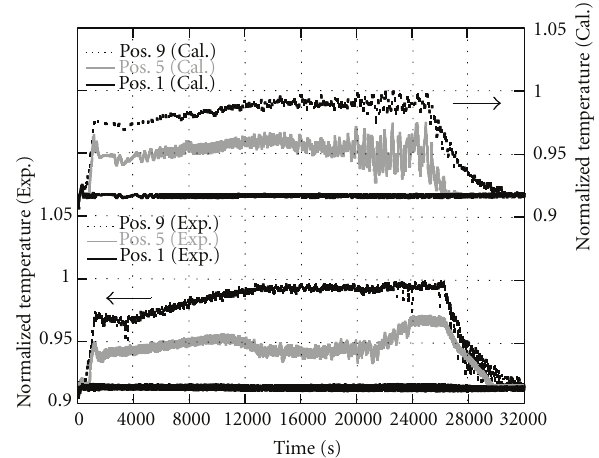
Figure 17: LSTF and RELAP5 results for fluid temperatures in secondary-side of SG Tube 3 in loop with PZR at Positions 1, 5, and